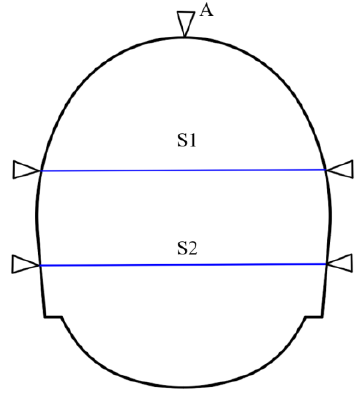
Figure 10. Field monitoring schematic. The analysis of the tunnel deformation near the penetration working face revealed that at mileage YD2K100+595, the accumulated settlement of the vault was 9.61 cm, the horizontal convergence of measurement line S1 was 9.62 cm, and the horizontal conver- gence of measurement line S2 was 7.18 cm. At mileage YD2K100+605, the accumulated settlement of the vault was 10.5 cm, the horizontal convergence of measurement line S1 was 9.14 cm, and the horizontal convergence of measurement line S2 was 8.84 cm. The field monitoring results were compared with the numerical simulation results (Figure 11).